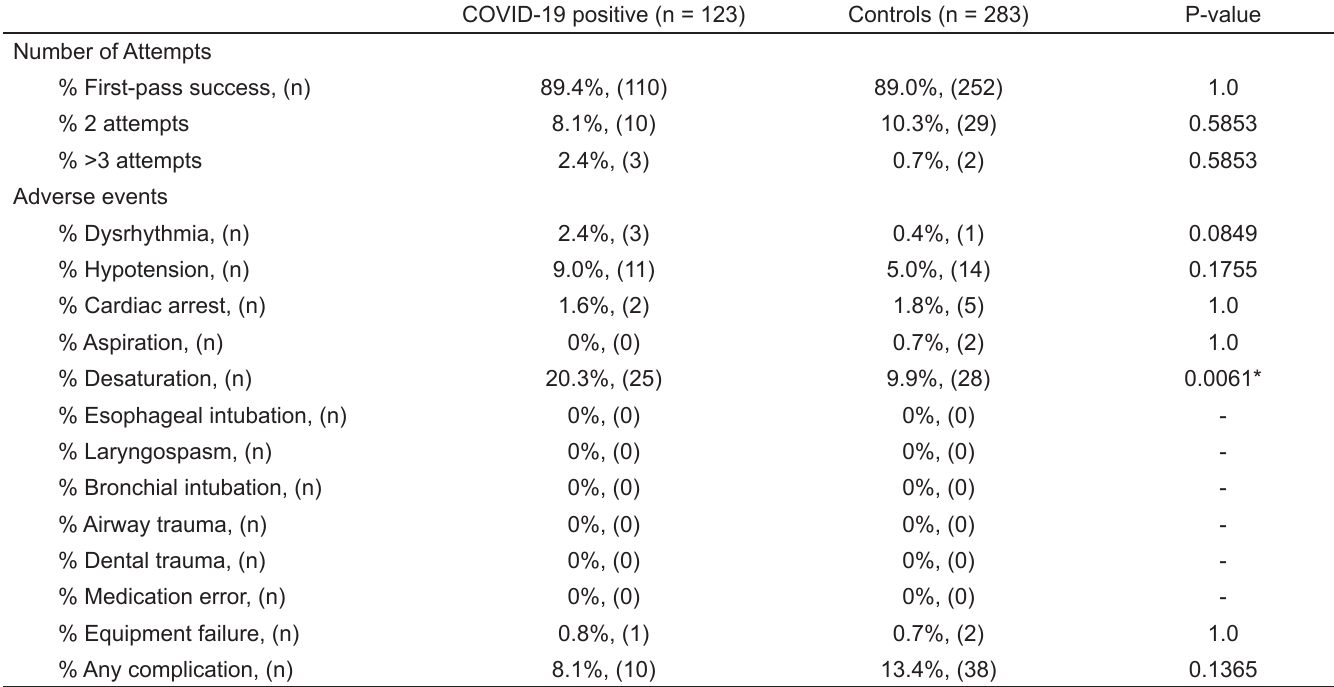
Table 4. First-pass success, multiple attempts, and incidence of complications associated with COVID-19 compared with controls. An asterisk indicates where α < 0.05.